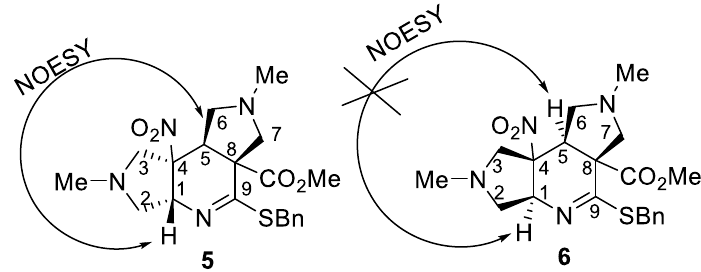
Figure 1. Selected interactions in 2D NOESY spectra of compound 5 , 6.